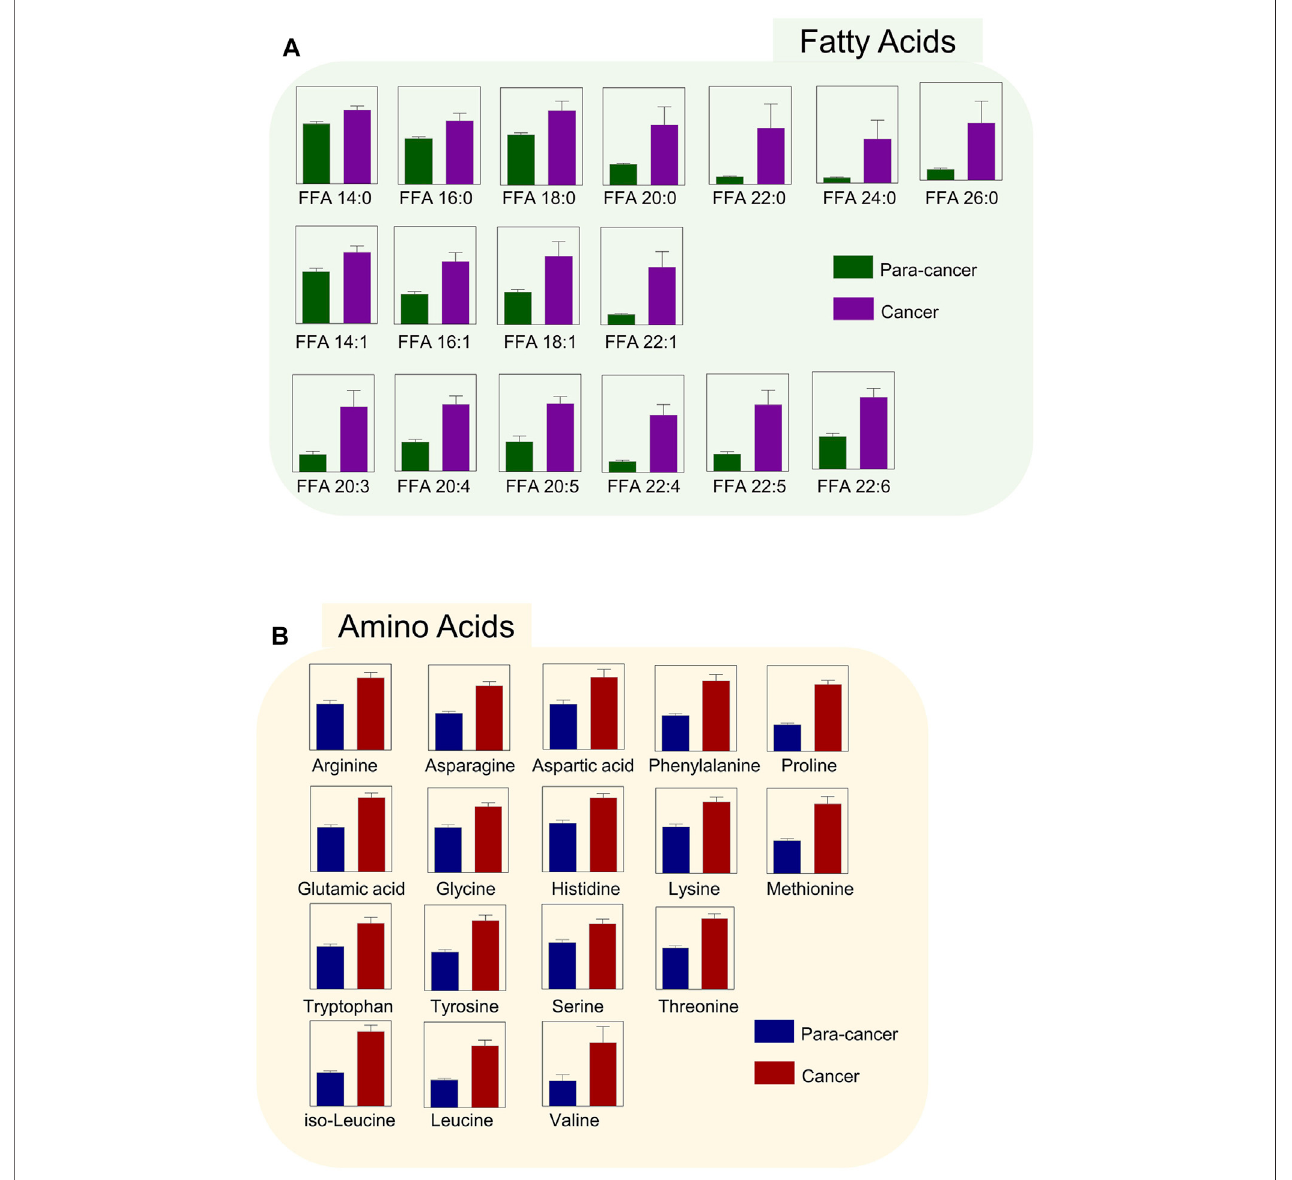
FIGURE 3 | Upregulated (A) fatty acids and (B) amino acids were identi fi ed in ESCC tissues. ( n (cid:2) 28. Data were expressed as mean ± SEM, p < 0.05.)